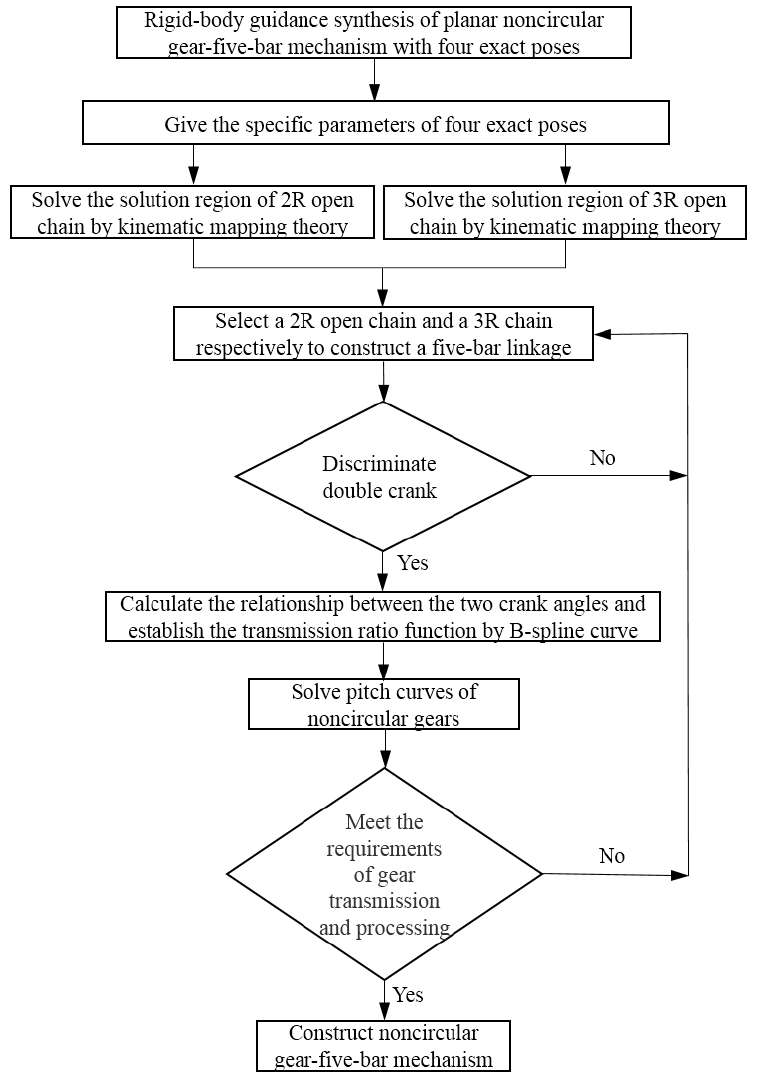
Figure 4. Design flow chart of noncircular gear-five-bar mechanism with four pose constraints.